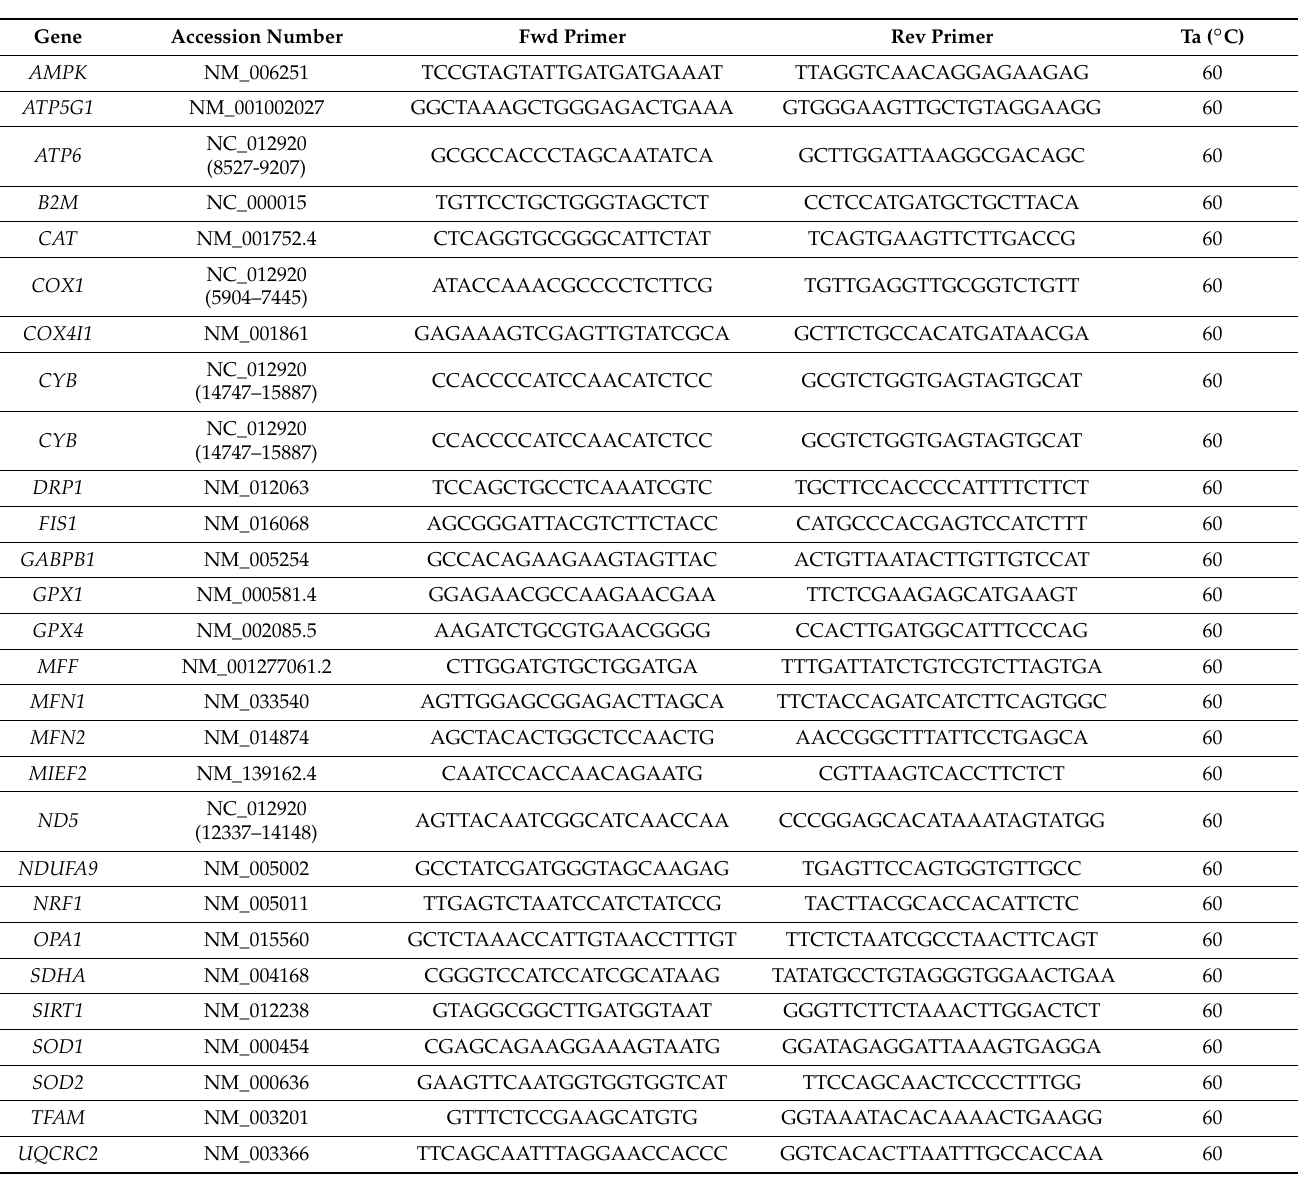
Table 2. List of forward (Fwd) and reverse (Rev) primers used for real time-PCR, respective gene, accession number, and annealing temperature (Ta) for genes used in the calculation of mtDNA copy number and for genes encoding electron transport chain complex and ATP synthase subunits, proteins involved in mitochondrial fission and fusion, antioxidant enzymes, mitochondrial biogenesis- related gene transcripts, and mitochondrial biogenesis-related gene transcripts. CYB : cytochrome b; B2M : β 2 microglobulin; ATP5G1 : ATP synthase membrane subunit c locus 1; ATP6 : ATP synthase membrane subunit 6; COX1 : cytochrome c oxidase I; COX4I1 : cytochrome c oxidase subunit 4I1; CYB: cytochrome b; ND5: NADH: Ubiquinone oxidoreductase core subunit 5; NDUFA9 :